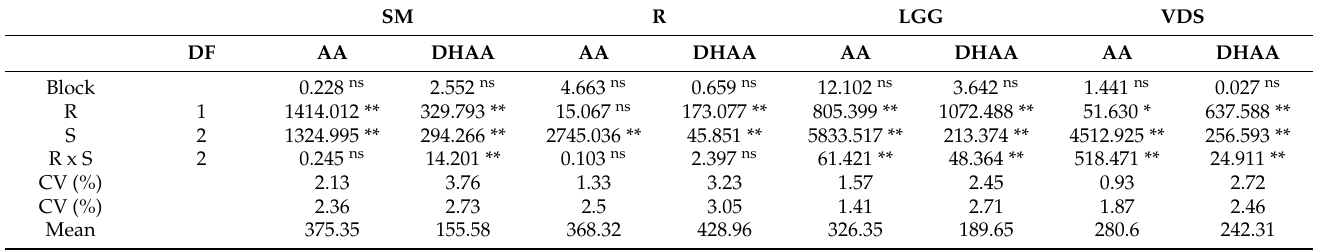
Table 1. F-values, degree of freedom (DF), and coefficient of variation (CV) values of AA and DHAA concentrations in juices from different scion/rootstock combinations after 35 days of storage. R LGG